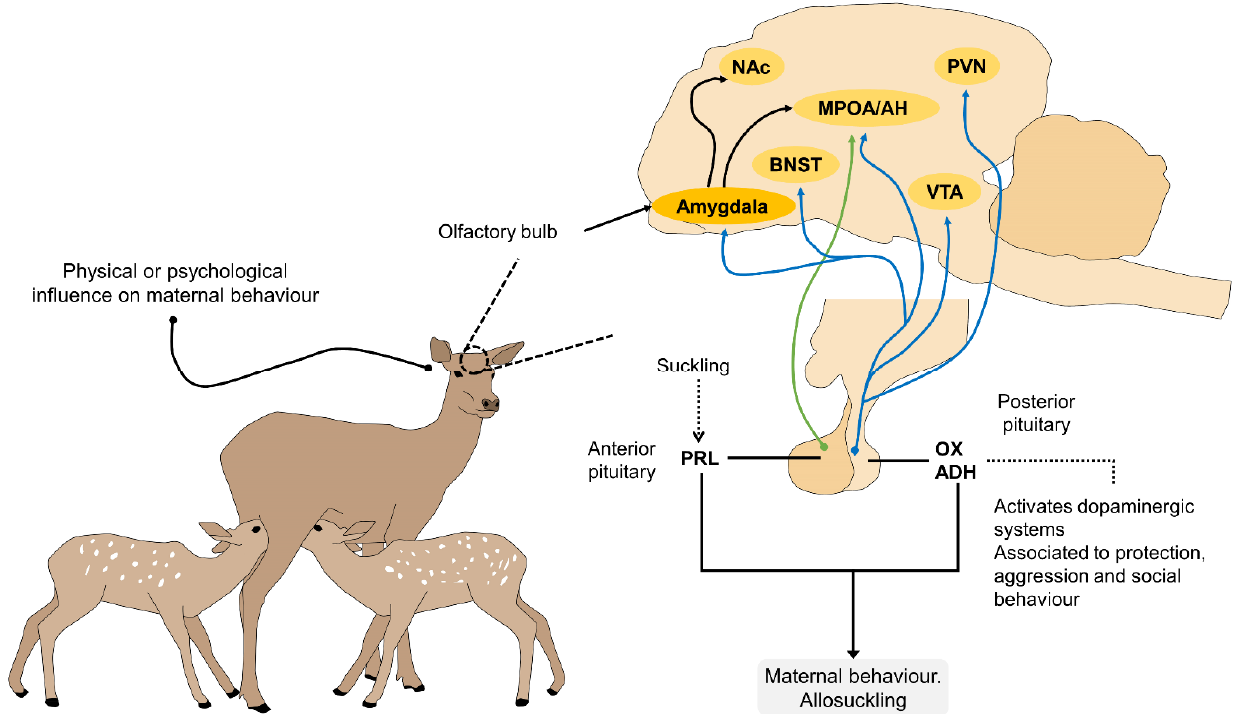
Figure 3. The neurophysiology of maternal behavior, milk let down, suckling and allosuckling. The main hormones associated with these processes (PRL, OX and ADH) act on different cerebral structures. The OX response is mediated by the VTA, PVN, amygdala, BNST and MPOA/AH. PRL site of action is in the MPOA/AH. The amygdala, NAc and BDNST also have a role in the reward system and maternal memory, and the former in the olfactory recognition of the offspring. ADH: antidiuretic hormone; BNST: bed nucleus of the stria terminalis; MPOA/AH: medial preoptic area/anterior hypothalamus; NAc: nucleus accumbens; OX: oxytocin; PRL: prolactin; PVN: paraventricular nucleus; VTA: ventral tegmental area [110–114].